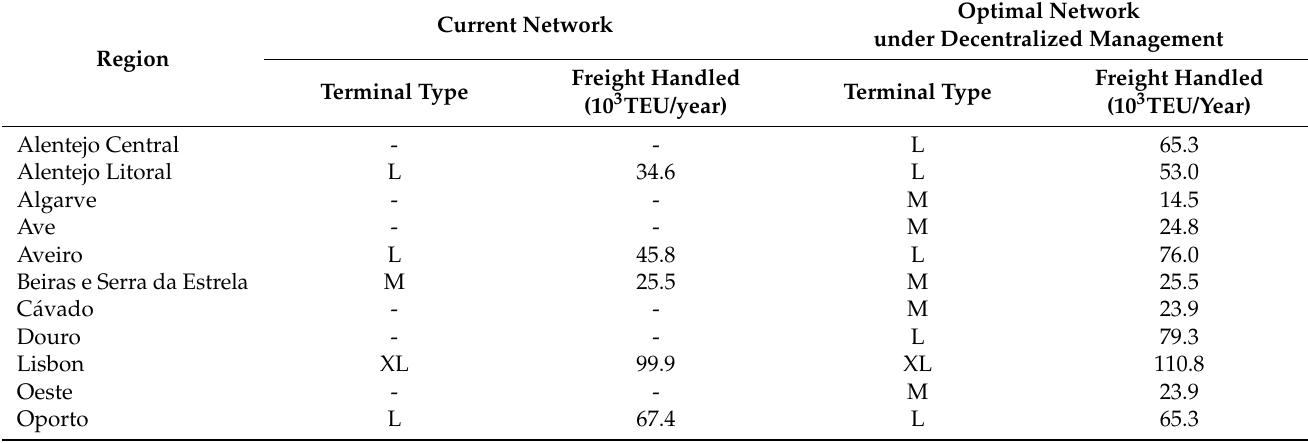
Table 6. Freight handled by the intermodal